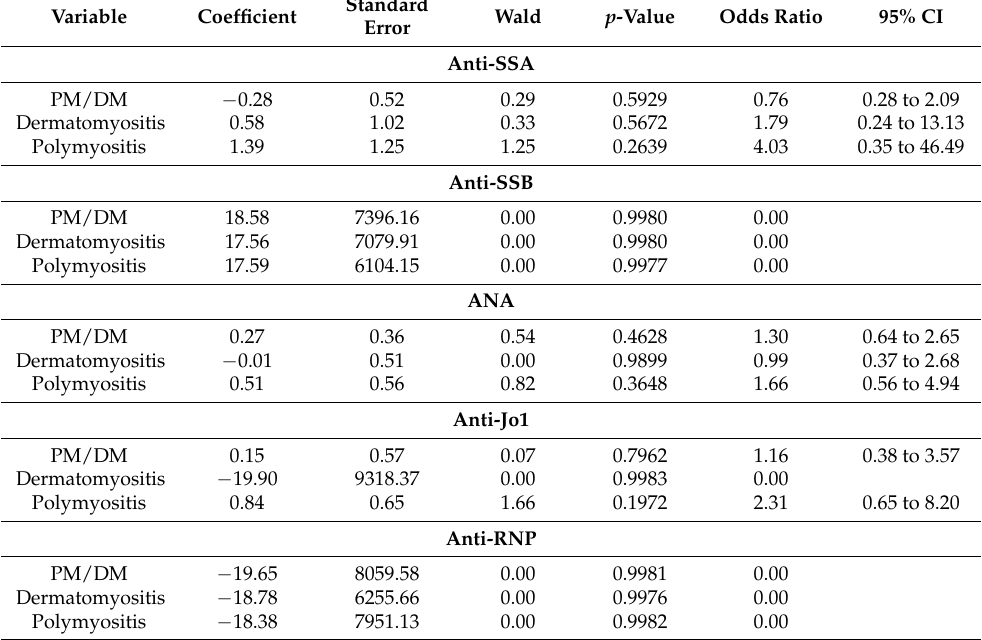
Table 3. Multivariable logistic regression analysis examining the association between autoantibodies and the risk of developing epilepsy for PM/DM overall and stratified according to dermatomy- ositis and polymyositis.